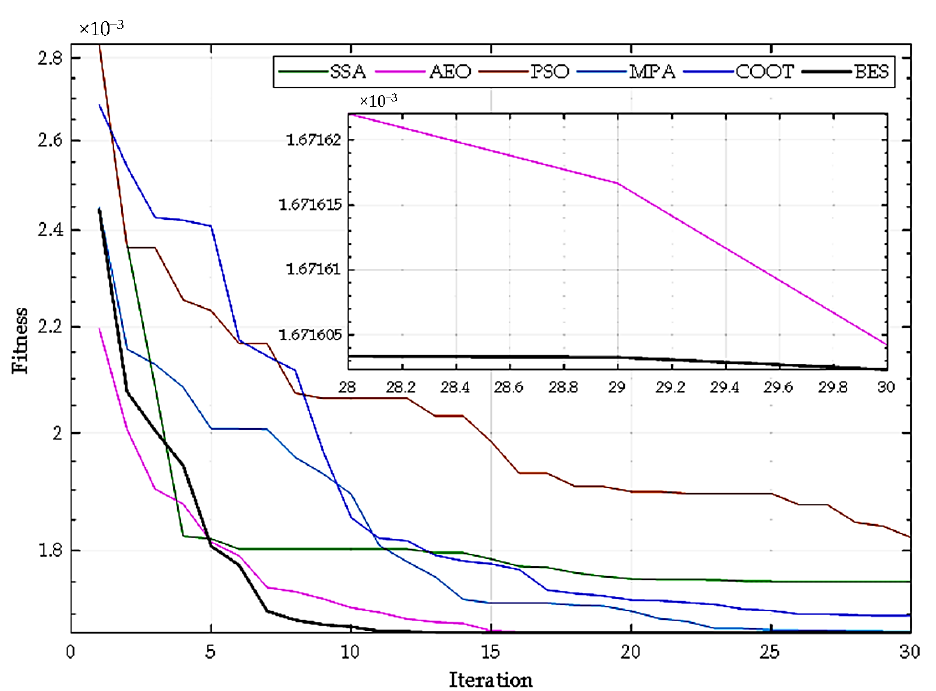
Figure 8. Mean fitness evolution as a function of the iterations.